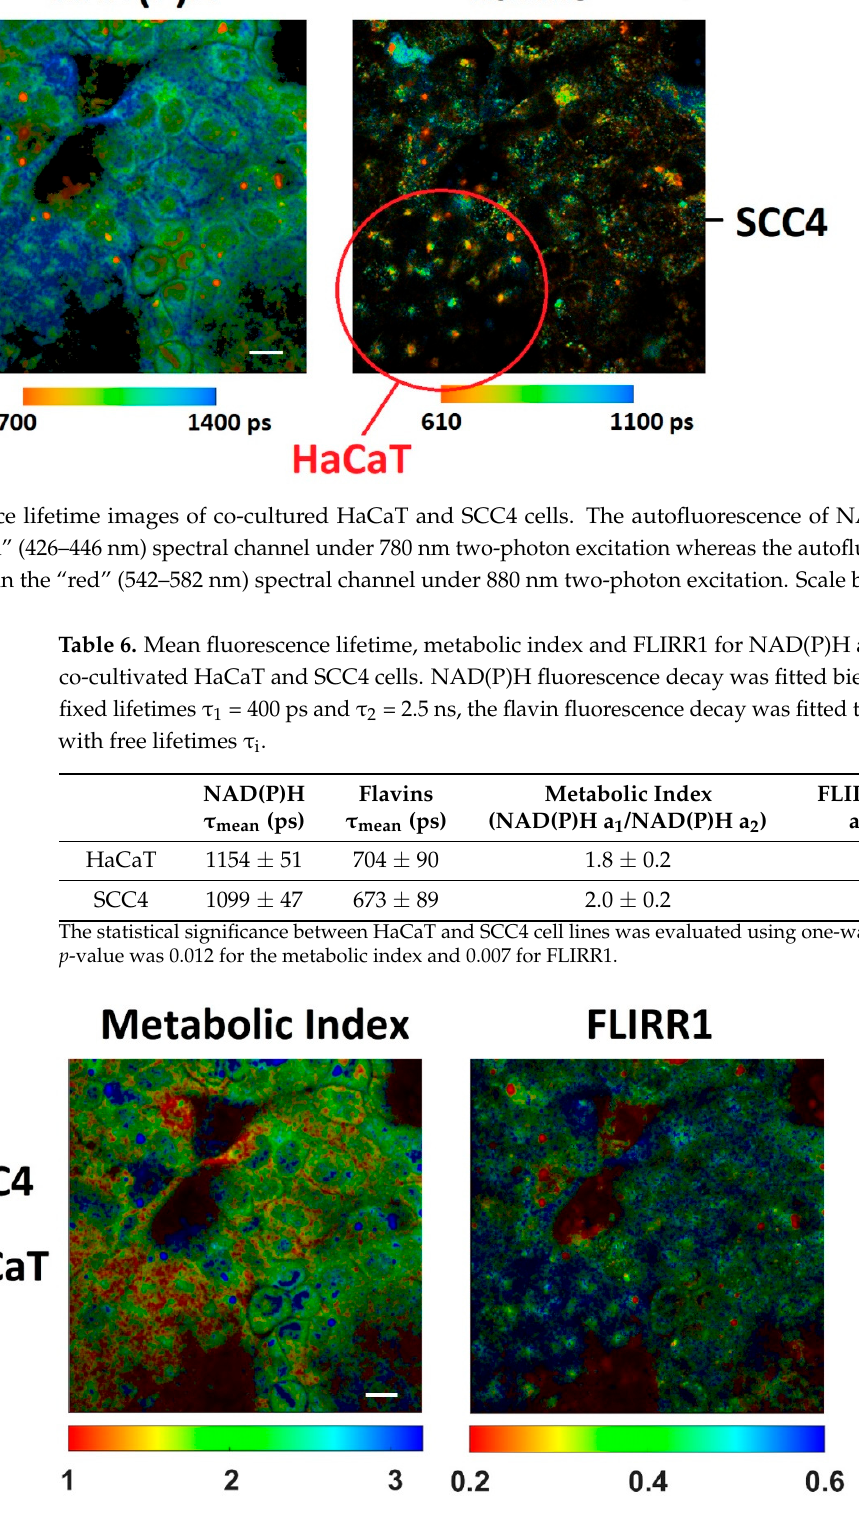
Figure 5. Intracellular distribution of the metabolic index and the redox ratio FLIRR1 within co-cultured HaCaT and SCC4 cells. Scale bar 20 µm.